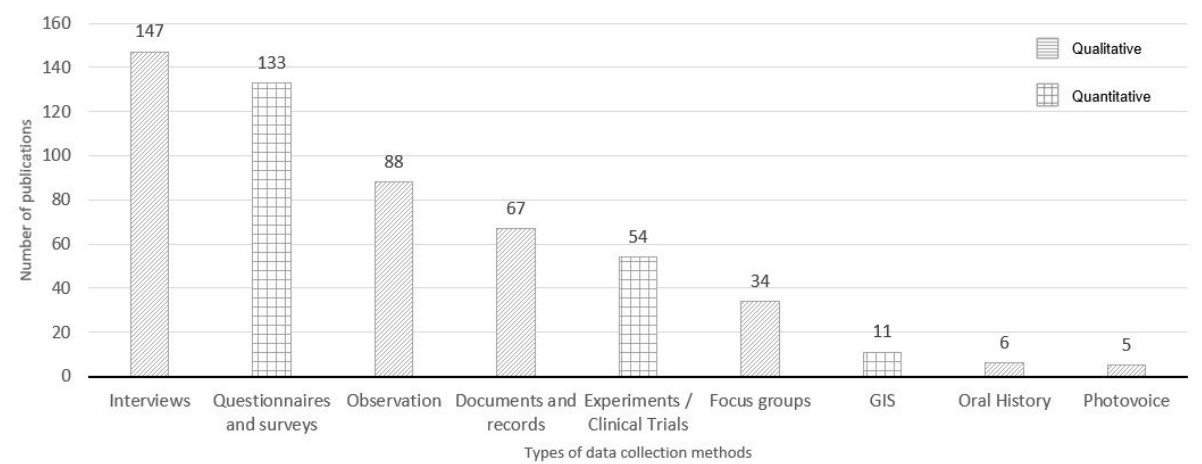
Figure 9. Types of data collection methods used in the studies examined. Note: Because many papers used more than one data collection method, the total number of publications represented in this chart exceeds the total number of unique papers part of the sample of publications ( n = 272) analyzed in this paper.